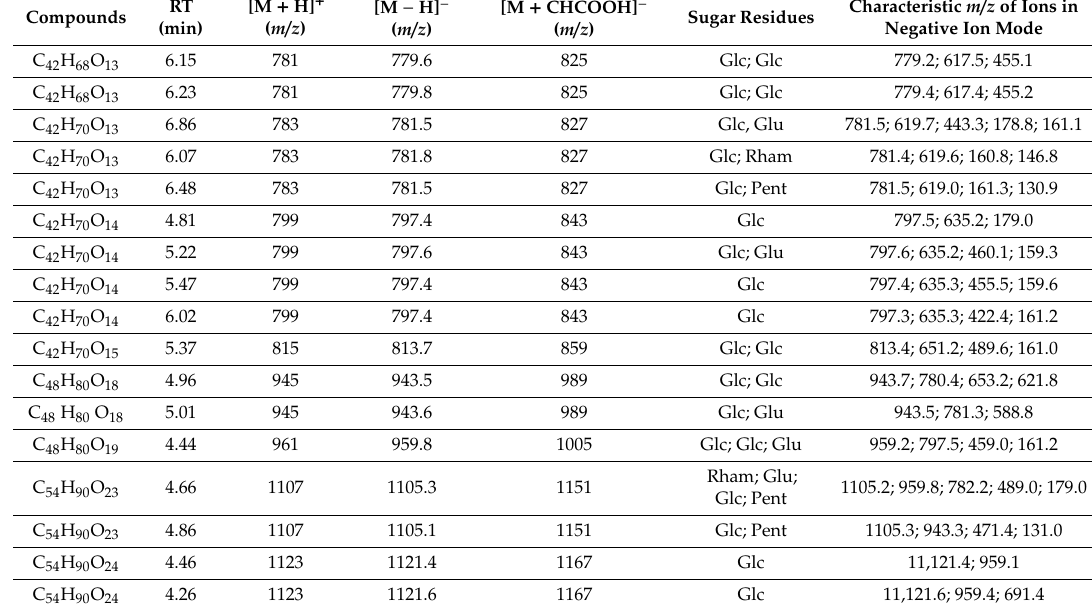
Table 1. Partial identification of saponins in Pa LE by UPLC-DAD.